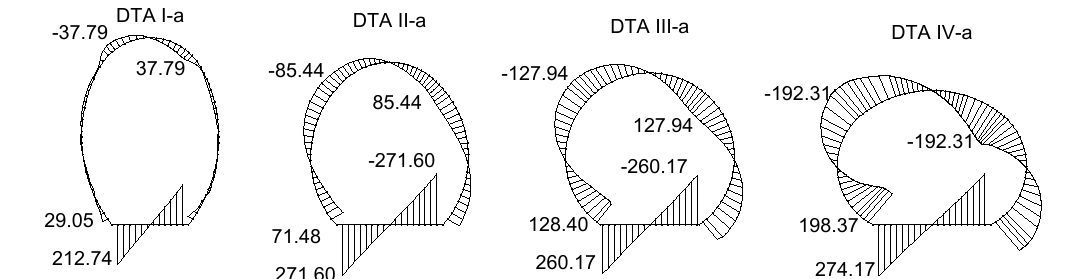
Figure 11. Diagrams of shear force (kN) for culverts defined by three